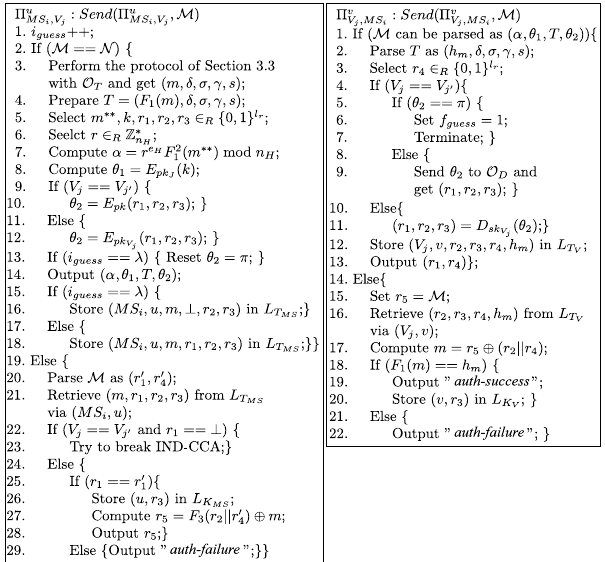
Figure 13. The actions of Π u queries,